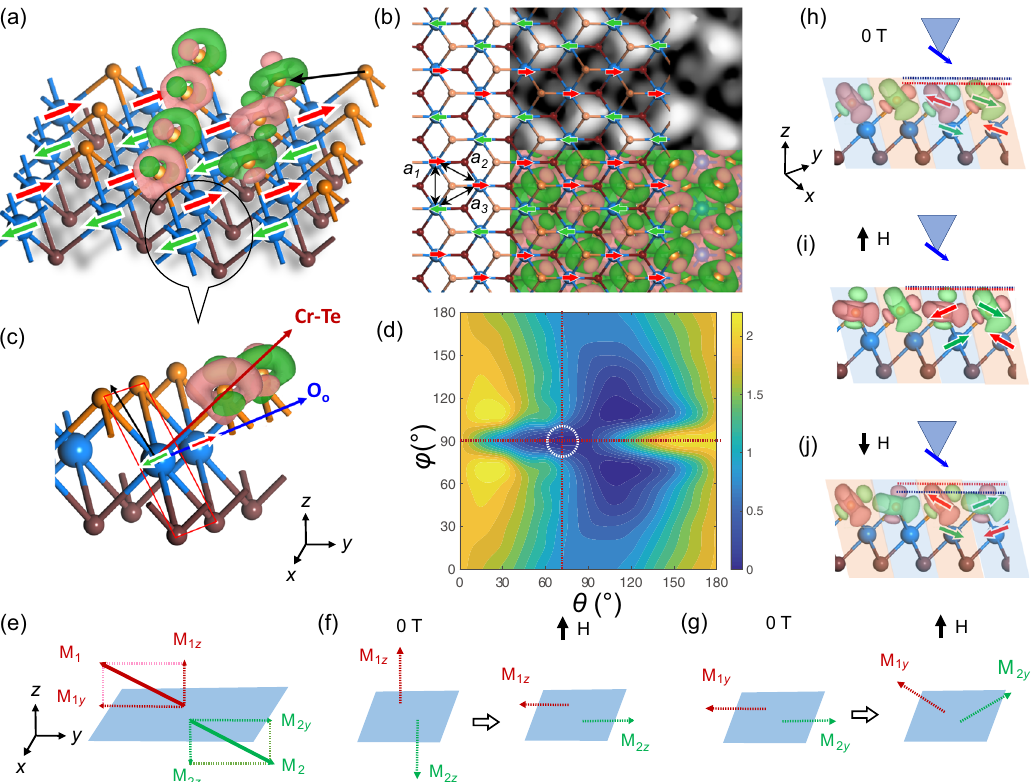
Fig. 3 Zigzag AFM order and spin reorientation transition in ML CrTe 2 . a Perspective view of the CrTe 2 ML in the zigzag AFM order. Green and red arrows represent the magnetisation directions of Cr atoms. Spin density contours of the selected Te atoms are plotted with an isosurface value of 0.001 e / Bohr 3 , where the red (green) contours denote the spin-up (spin-down). b Top view of the CrTe 2 ML in the zigzag order, superimposed on the DFT- simulated SPSTM image (top) and the spin density contours of the Te atoms (bottom). c Magnetisation axes in the MAE calculation. x , y and z axes correspond to the directions of the lattice vectors. A Cr-Te plane is marked with a red rectangular. d Angular dependence of the calculated MAE. Here, θ and ϕ correspond to the angles between the magnetisation direction and the z and x axes, respectively. A step size of 10° is used in our calculations. The total energy of the Cr moment oriented to the O o direction was chosen as the zero-energy reference. e Schematics showing magnetic moments, M 1 and M 2 , of two adjacent Cr coupled antiferromagnetically, which are decomposed along the z and y axes (dashed arrows). f , g Evolution of the z -component ( f ) and y -component ( g ) of the magnetic moments under a vertical fi eld. h – j Schematics of the SPSTM measurement con fi gurations under different magnetic fi eld directions. The ML CrTe 2 is viewed along the black arrow in ( a ). The tip magnetisation direction is represented with blue arrows. Magnetisation directions of the Cr moment and the Te- p x/y orbitals are